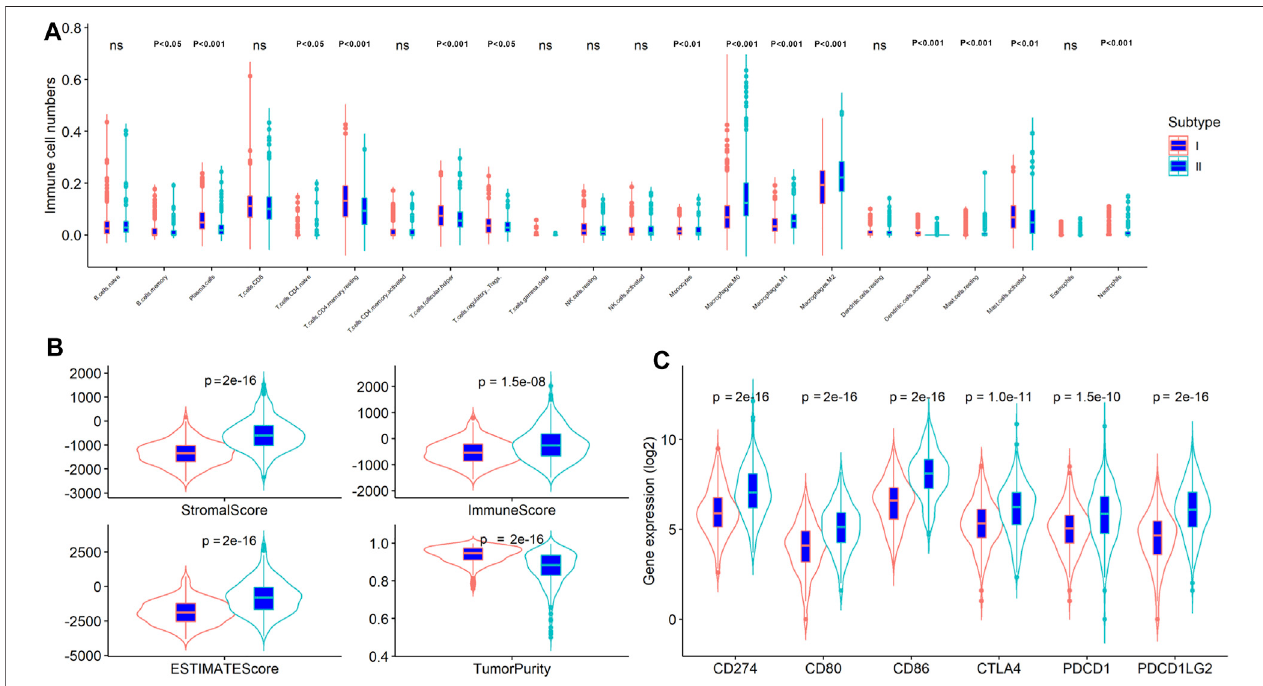
FIGURE 5 | The stemness subtypes had distinct TME patterns in CRC. Comparison of (A) TIICs; (B) immune, stromal, ESTIMATE scores and tumor purity; (C) Immune checkpoint inhibitors between stemness subtype I and stemness subtype II.